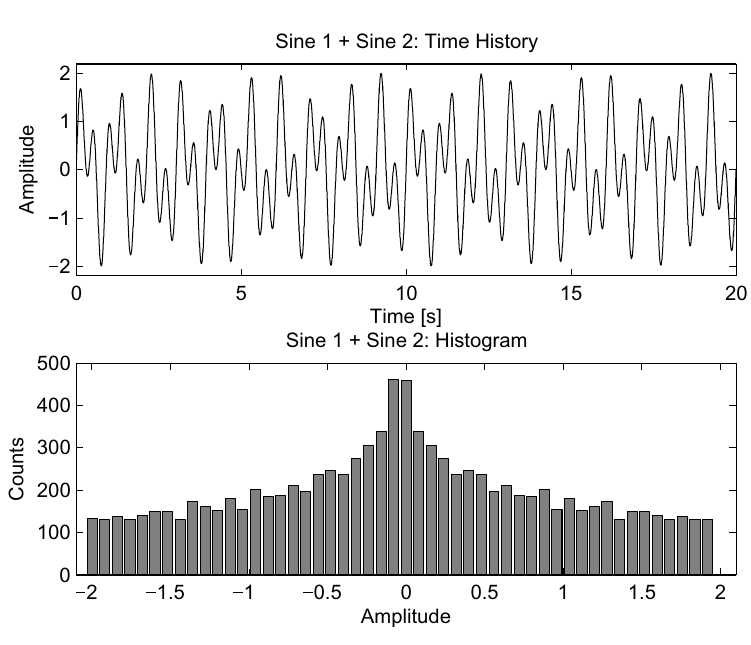
Fig. 3. 2.3 Hz sinusoid and histogram – ku ex = − 1.5.